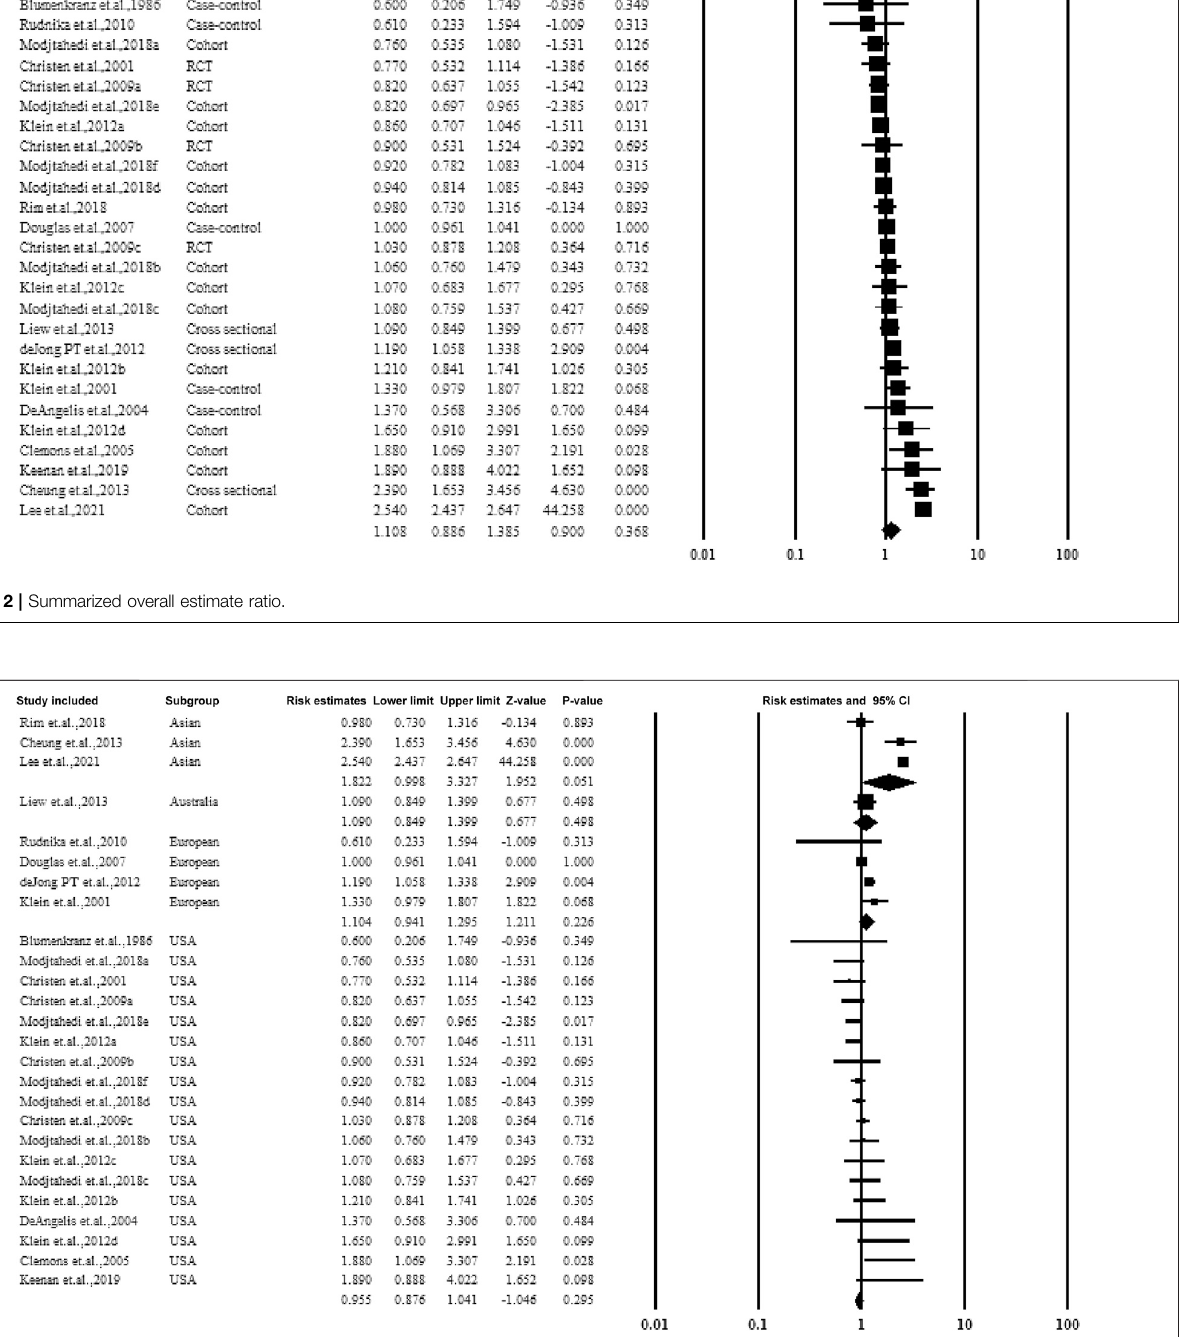
FIGURE 3 | Summarized subgroup analysis according to the study